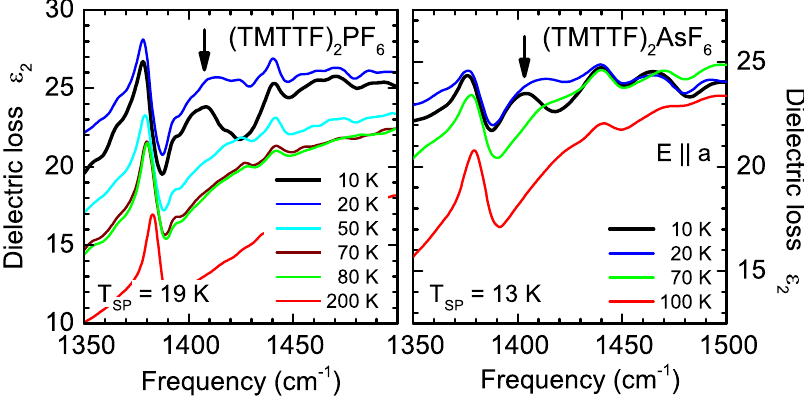
Figure 32. The dielectric losses (cid:15) around 1410 cm − 1 (indicated by the arrows) that builds up when the temperature drops = 19 and 13 K, respectively. The measurements have been performed with below T SP light polarized parallel to the